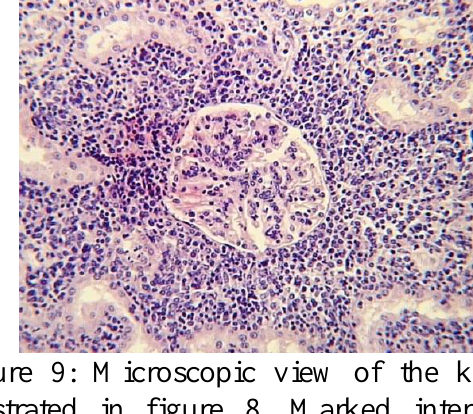
Figure 8: kidney of a cow infected with Theileria annulata parasites. Variable sized, pale white areas are seen on the cortical surface.